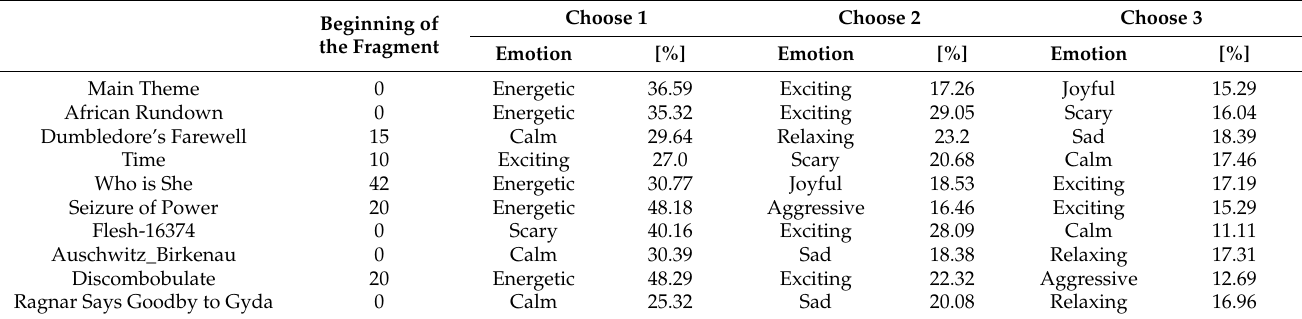
Table 12. Results of the application and subjective responses.